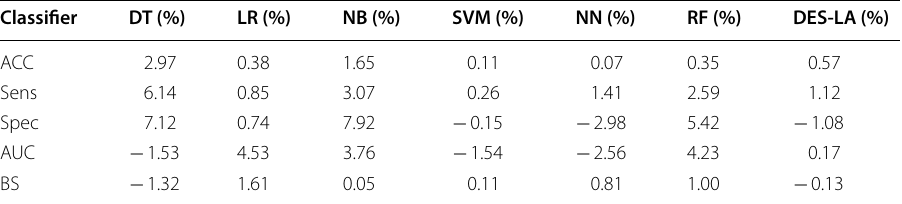
Table 4 Difference between performance measures with and without filtering over all